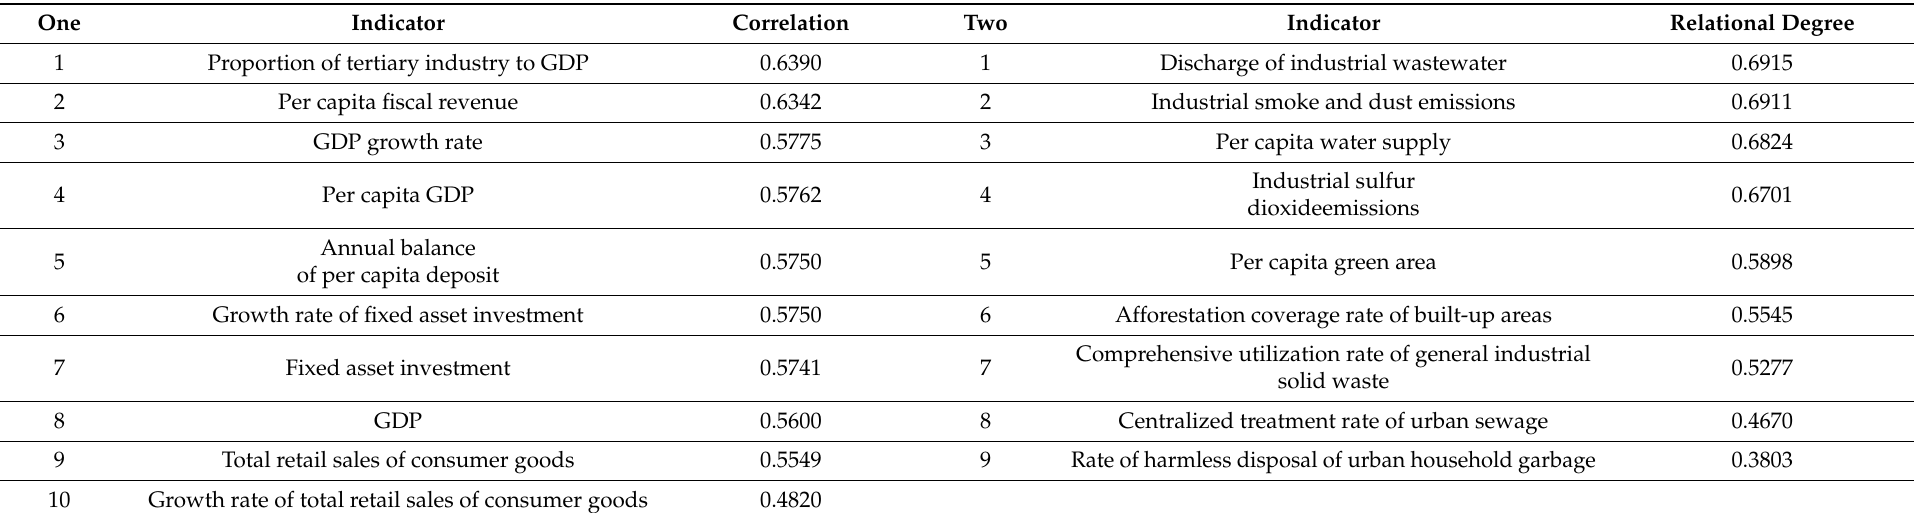
Table 4. 2019 YUA ED System and EE System Relevance